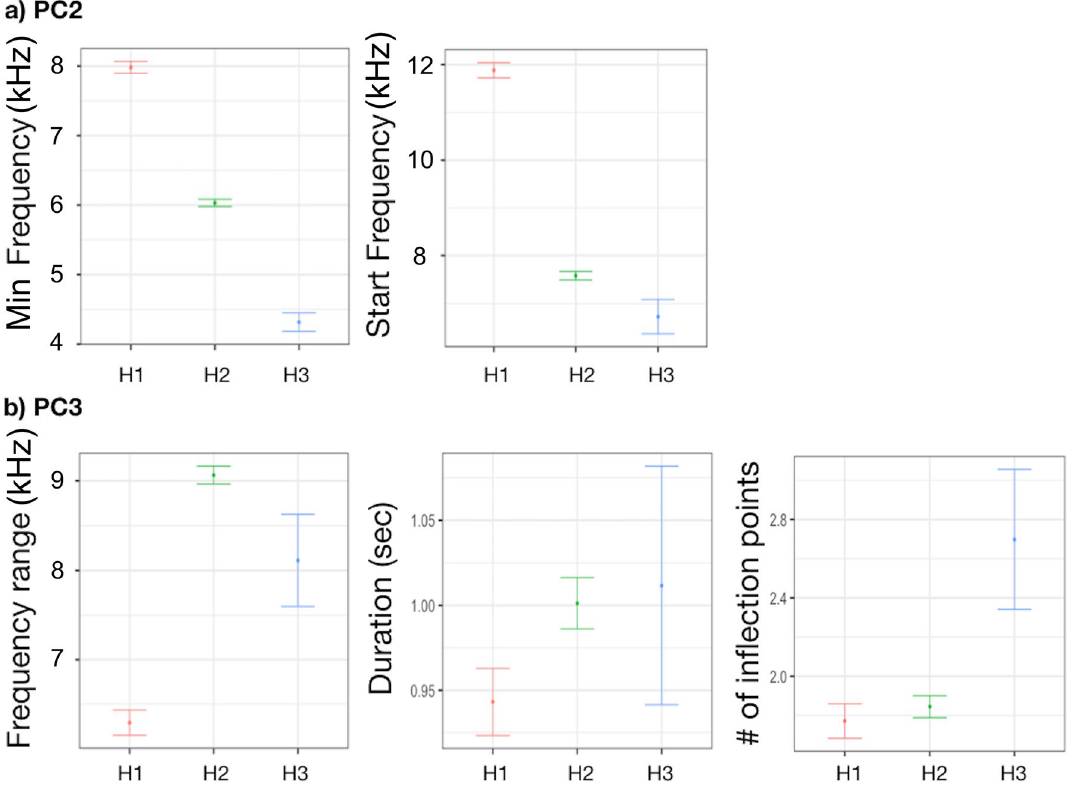
Figure 5. Effect of ‘sea bottom’ on ( a ) min and start frequencies (PC2) and ( b ) frequency range, duration and number of inflection points